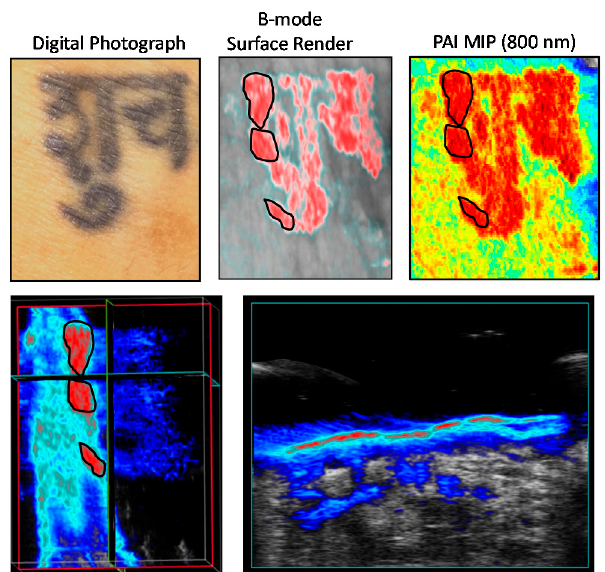
Figure 3. PAI of an intradermal tattoo . The panel of images on the top represents digital photograph (left), a B-mode surface rendering (middle), and a reconstructed maximum intensity projection (MIP; right) image (800 nm) of a black tattoo on the wrist of a healthy volunteer. Corresponding longitudinal (left) and transverse axial (right) images of a part of the tattoo (outlined in black) is shown. The images have been pseudo-colorized for enhanced